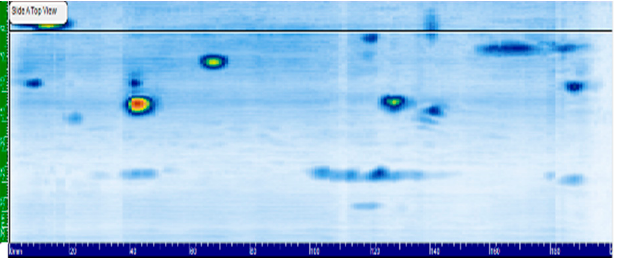
Figure 5. Example of TFM results (Side A, side view).